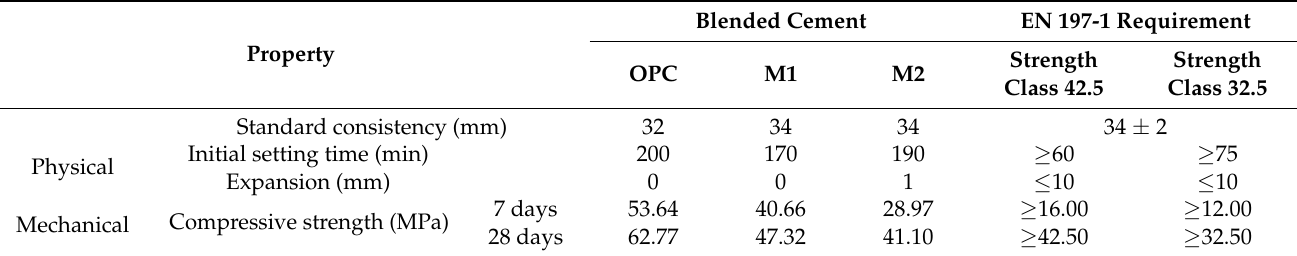
Table 2. New cement physical and mechanical